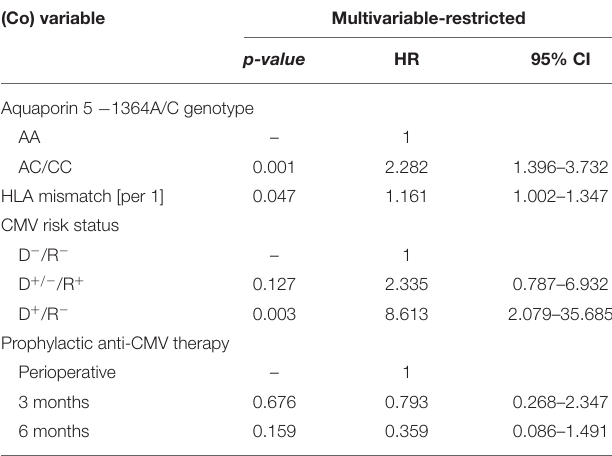
TABLE 4 | Restricted multivariable Cox regression analysis of kidney transplantation recipients with respect to the effect on cytomegalovirus infection risk.